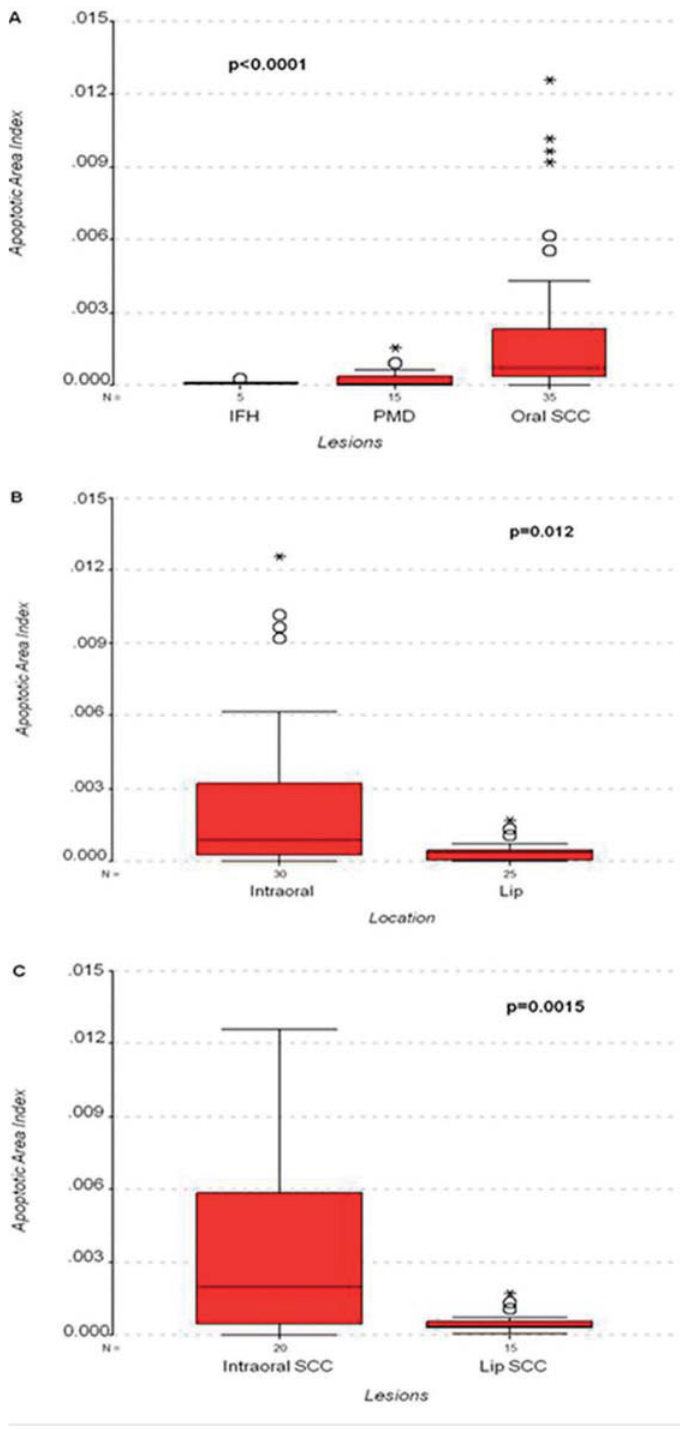
Figure 2- (cid:3)(cid:39)(cid:76)(cid:86)(cid:87)(cid:85)(cid:76)(cid:69)(cid:88)(cid:87)(cid:76)(cid:82)(cid:81)(cid:3)(cid:82)(cid:73)(cid:3)(cid:68)(cid:85)(cid:72)(cid:68)(cid:3)(cid:71)(cid:72)(cid:81)(cid:86)(cid:76)(cid:87)(cid:76)(cid:72)(cid:86)(cid:17)(cid:3)(cid:36)(cid:16)(cid:3)(cid:76)(cid:81)(cid:192)(cid:68)(cid:80)(cid:80)(cid:68)(cid:87)(cid:82)(cid:85)(cid:92)(cid:3)(cid:191)(cid:69)(cid:85)(cid:82)(cid:88)(cid:86)(cid:3)(cid:75)(cid:92)(cid:83)(cid:72)(cid:85)(cid:83)(cid:79)(cid:68)(cid:86)(cid:76)(cid:68)(cid:3)(cid:11)(cid:44)(cid:41)(cid:43)(cid:12)(cid:15)(cid:3)(cid:83)(cid:82)(cid:87)(cid:72)(cid:81)(cid:87)(cid:76)(cid:68)(cid:79)(cid:79)(cid:92)(cid:3)(cid:80)(cid:68)(cid:79)(cid:76)(cid:74)(cid:81)(cid:68)(cid:81)(cid:87)(cid:3)(cid:71)(cid:76)(cid:86)(cid:82)(cid:85)(cid:71)(cid:72)(cid:85)(cid:3)(cid:11)(cid:51)(cid:48)(cid:39)(cid:12)(cid:15)(cid:3) and oral squamous cell carcinoma (SCC) lesions. B- Intraoral and lower lip locations. C- Intraoral squamous cell carcinoma (SCC) and lower lip (cid:69)(cid:72)(cid:70)(cid:68)(cid:88)(cid:86)(cid:72)(cid:3)(cid:82)(cid:73)(cid:3)(cid:87)(cid:75)(cid:72)(cid:3)(cid:71)(cid:76)(cid:73)(cid:191)(cid:70)(cid:88)(cid:79)(cid:87)(cid:92)(cid:3)(cid:76)(cid:81)(cid:3)(cid:70)(cid:82)(cid:79)(cid:79)(cid:72)(cid:70)(cid:87)(cid:76)(cid:81)(cid:74)(cid:3)(cid:86)(cid:68)(cid:80)(cid:83)(cid:79)(cid:72)(cid:86)(cid:3)(cid:82)(cid:73)(cid:3) normal epithelium. Areas of apparently benign epithelium adjacent to the malignant tissue were used in some studies as a normal control group 1 . (cid:82)(cid:73)(cid:3)(cid:191)(cid:72)(cid:79)(cid:71)(cid:3)(cid:70)(cid:68)(cid:81)(cid:70)(cid:72)(cid:85)(cid:76)(cid:93)(cid:68)(cid:87)(cid:76)(cid:82)(cid:81) 13 , which asserts the occurrence